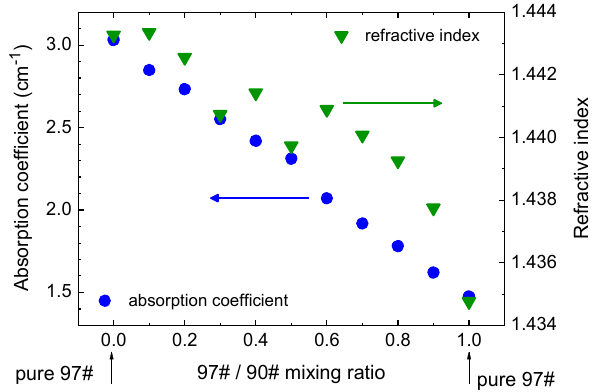
Figure 21. Refractive indices (green symbols, right axis) and absorption coefficients (blue symbols, left axis) at 1 THz of gasoline mixtures of 90# and 97# octane. Adapted from [148].